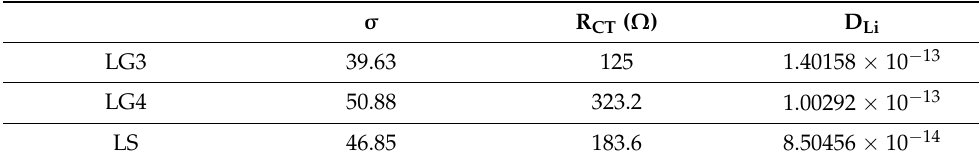
Table 5. Charge transfer resistance (Rct), Warburg factor ( σ ) and lithium ions diffusion coefficient (D Li ) of the assembled lithium batteries.